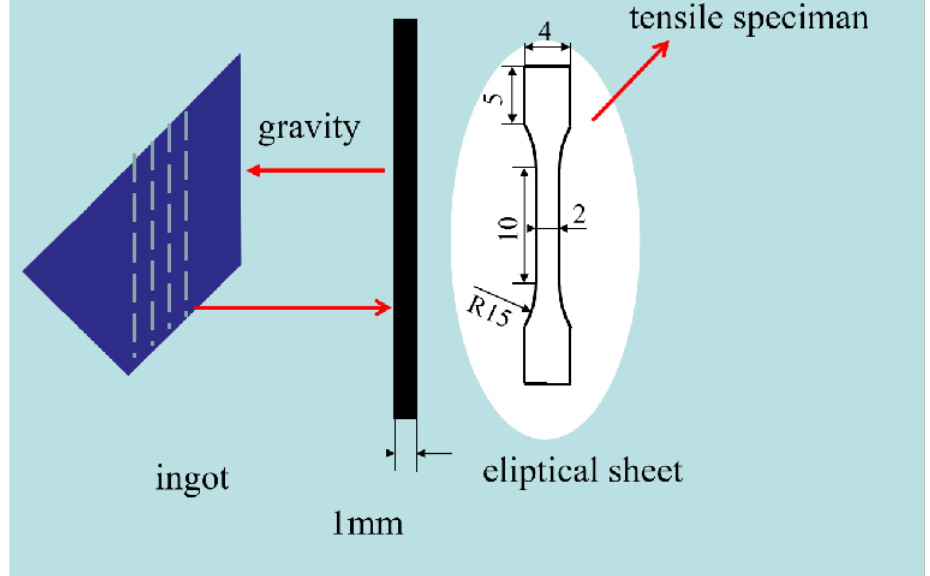
Figure 2. Schematic diagram of sampling of a tensile specimen.